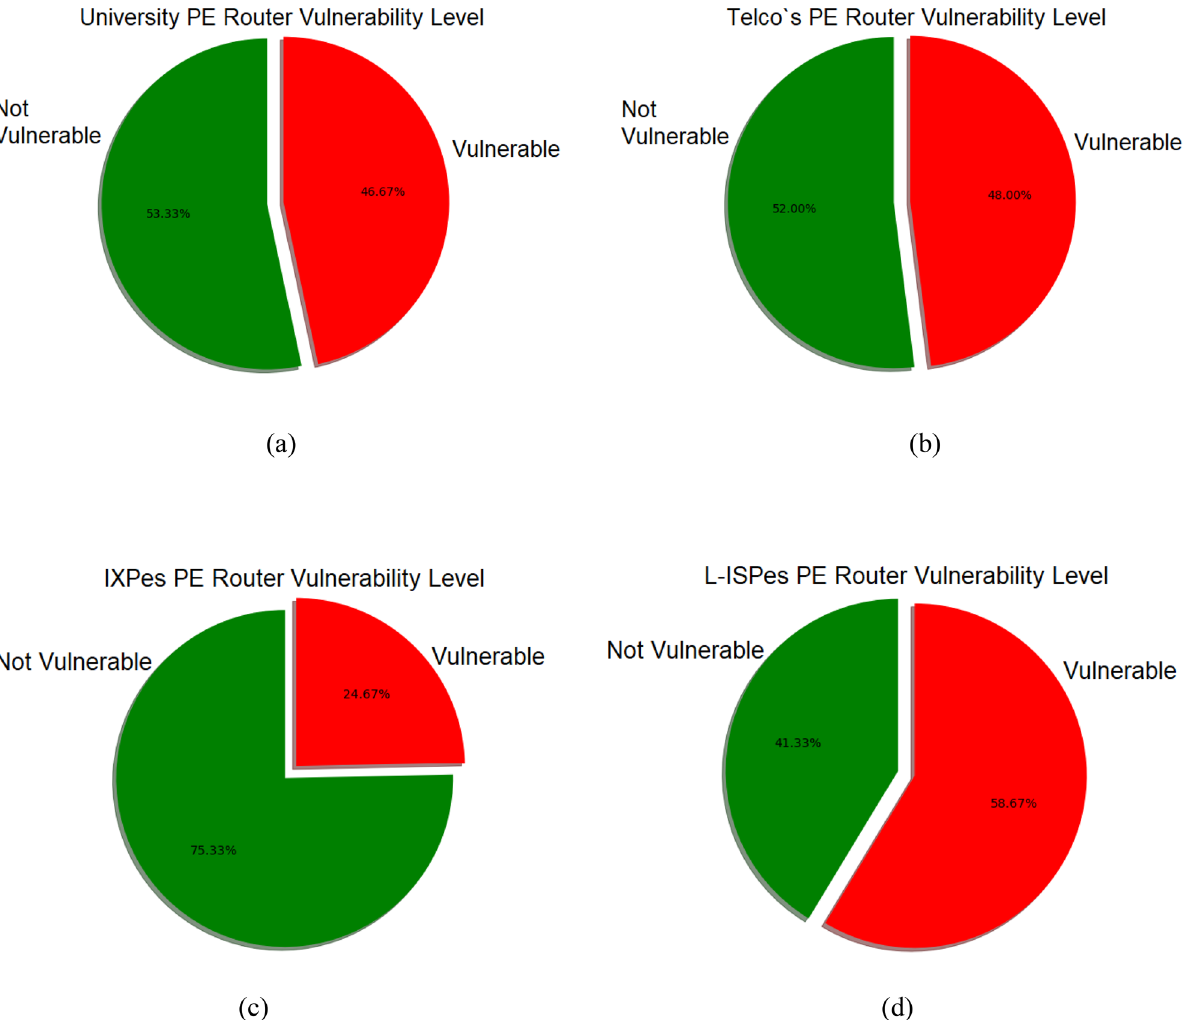
Figure 5. Different types of AS PE router vulnerability estimation.